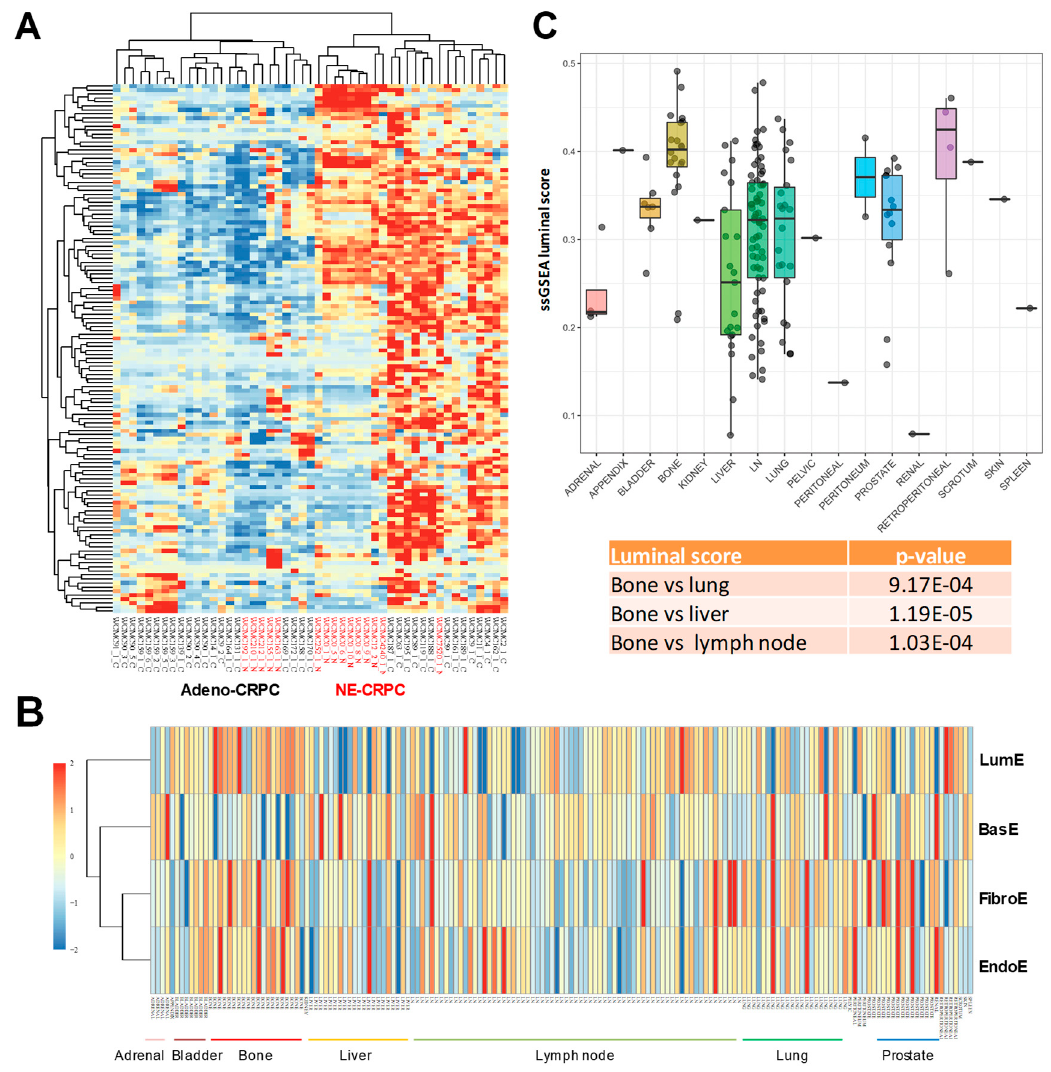
Figure 4. Enrichment scores in aggressive prostate tumors and metastases. ( A ) Unsupervised hierarchical clustering analysis of adenocarcinoma (Adeno) and neuroendocrine (NE) castration-resistant prostate cancers (CRPCs) based on luminal metagene expression. Note the presence of sub-clusters of both Adeno and NE CRPCs with di ff erent degrees of luminal enrichment. ( B ) Metagene score distribution in tissue samples from di ff erent metastatic sites. ( C ) Luminal enrichment scores in metastatic prostate tumors at distinct organ sites. p -values relative to the comparison of luminal enrichment scores between bone versus lung, liver, and lymph node metastases are indicated.